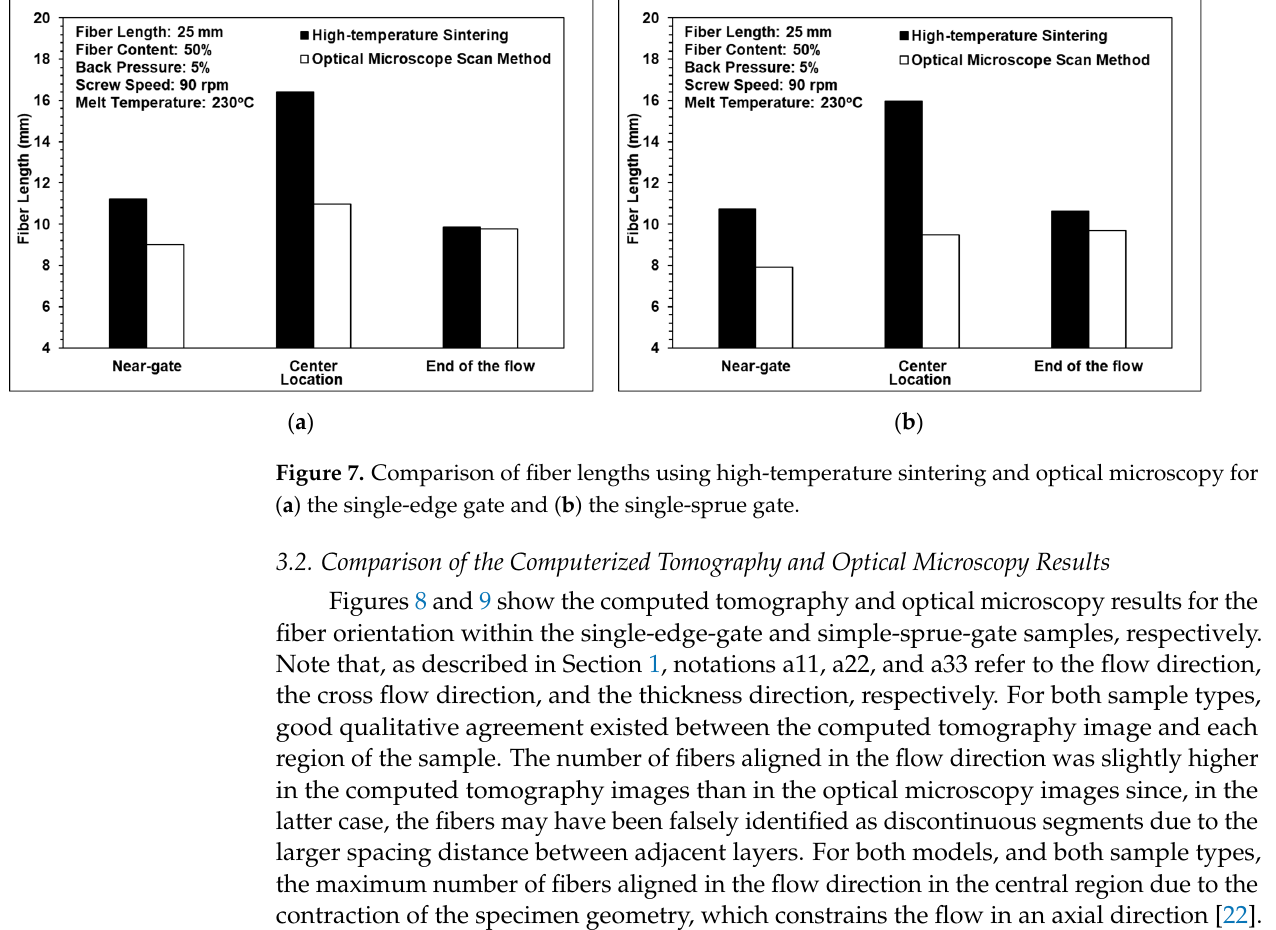
( b ) Figure 9. Comparison of the orientation tensor in ( a ) computed tomography and ( b ) optical micros- copy images of a single-sprue gate. 3.3. Fiber Length Analysis Figure 10 shows the effects of the back pressure, the screw speed, and the melt tem- perature on the fiber length. It can be observed that a fiber length of approximately 10 mm was maintained when the back pressure and the screw speed were assigned low values, of 0.7 MPa and 90 rpm, respectively. In other words, the three-barrel injection molding unit successfully protects the fibers from serious damage during the molding process pro- vided that the processing conditions (back pressure and screw speed) are appropriately set. As the back pressure and the screw speed increase, the shear strain rate acting on the